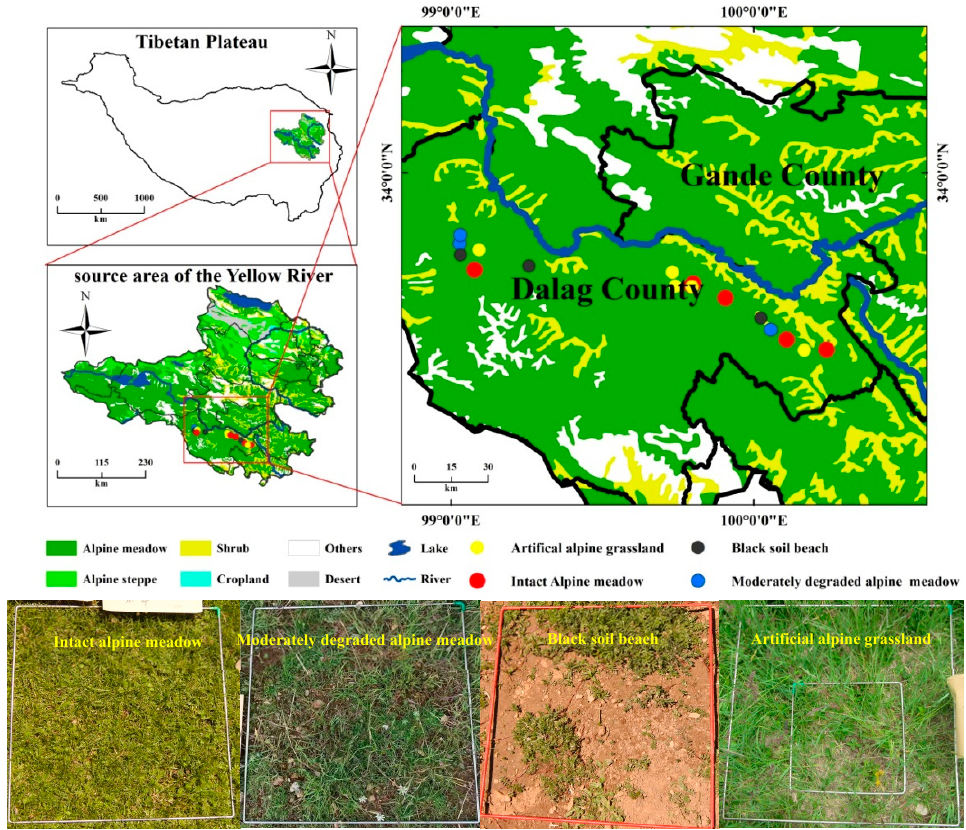
Figure 1. Study sites in the three-river source area of the Qinghai–Tibet Plateau. The border of the Qinghai–Tibet plateau quoted from Zhang et al. [26]; the border of the Three-River-Source National Park quoted from Wei (2018) [27].